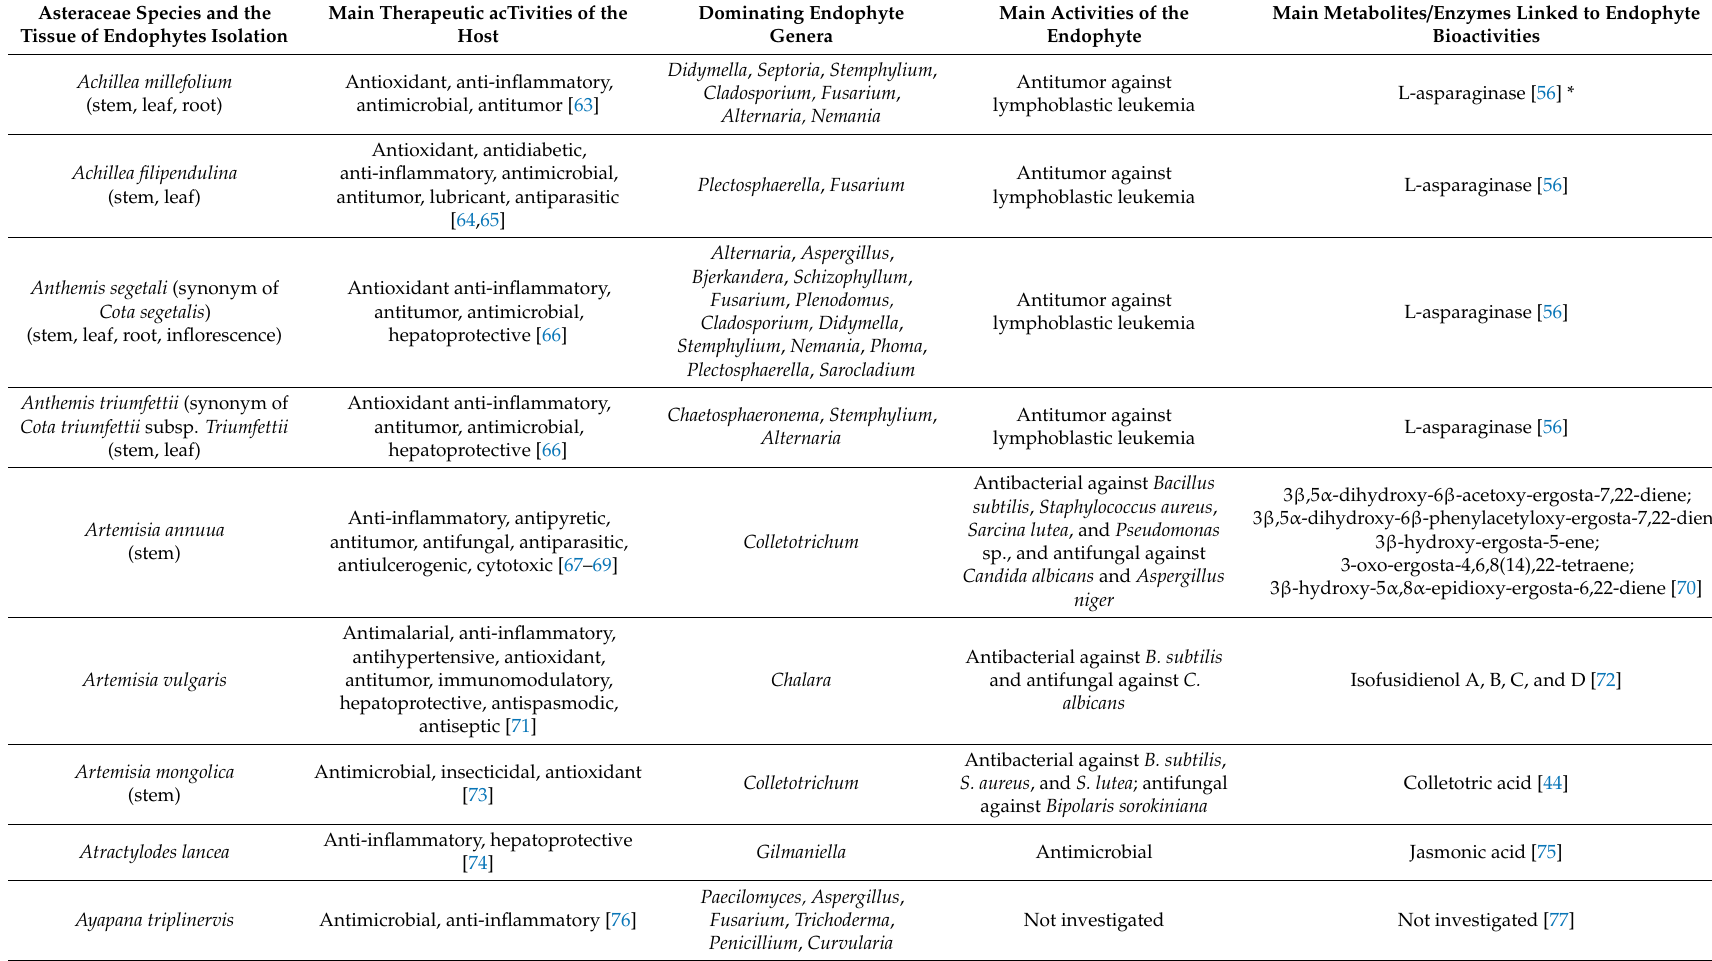
Table 1. Endophytes isolated from Asteraceae species with a therapeutic activity referred to host and / or endophyte